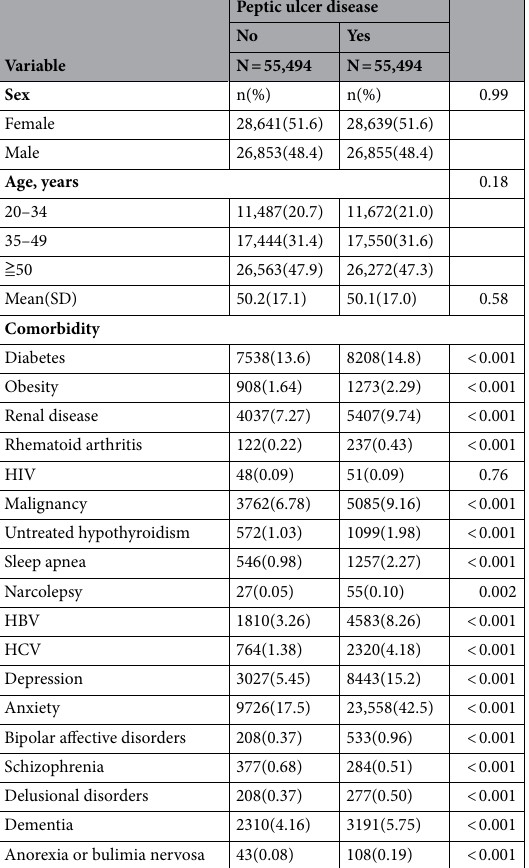
a diagnosis of CFS was made, patient withdrawal from the NHI program, death, or ultimately until the end of December 31, 2011. Statistical analysis. The distributions of sex, age, and comorbidity were compared between the PUD cohort and non-PUD cohort using the Chi-square test for categorical variables and Student’s t-test for continu- ous variables. We used Kaplan–Meier method to estimate the cumulative incidences of CFS for the PUD cohort and the non-PUD cohort and the log-rank test to compare the difference between the two cohorts. The incidence density rate of CFS for each cohort was estimated to be the number of CFS event occurrence divided by sum of follow-up time (per 1000 person-years). Univariable and multivariable Cox proportional hazards regression analyses were used to assess the CFS risk associated with PUD and estimate the hazard ratios (HRs) with 95% confidence intervals (CIs). The multivariable models included adjusting for age, sex, and comorbidities of diabe- tes, obesity, renal disease, rheumatoid arthritis, HIV, malignancy, untreated hypothyroidism, sleep apnea, narco- lepsy, HBV, HCV, depression, anxiety, bipolar affective disorders, schizophrenia, delusional disorders, dementia, anorexia and bulimia nervosa, and alcohol or other substance abuse. All analyses were performed using the SAS